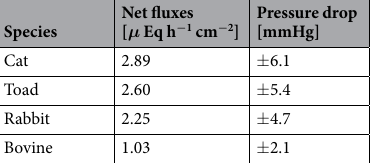
Table 1. Pressure drop evaluation of relation (8) on the basis of Cl − fluxes across the ciliary body or cyliary epitelium as summarized in ref.